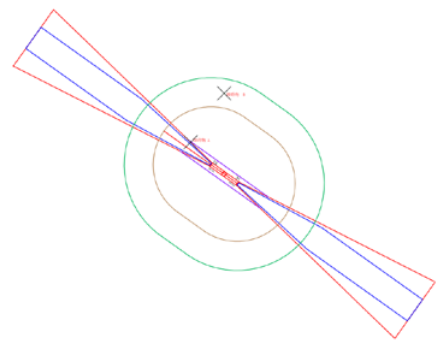
Fig. 4. Location relationship between obstacles and